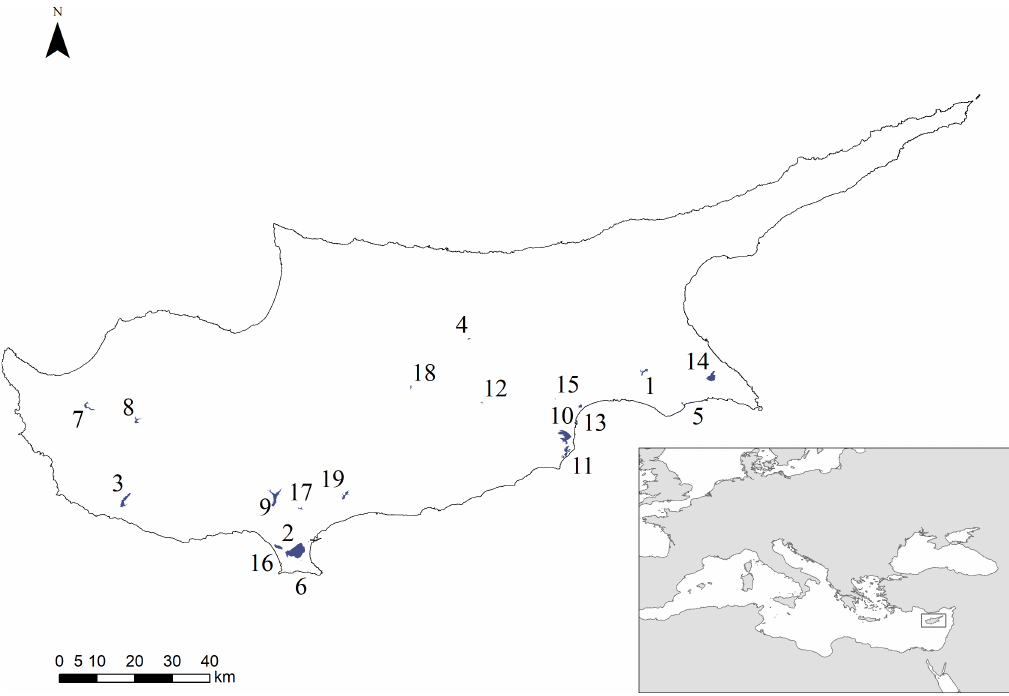
Fig 1. A map of Cyprus showing the location of the nineteen study sites. The numbers correspond to those in Table 1. The inset map on the bottom right corner shows Cyprus’ location in the eastern Mediterranean Sea (source: 2009–2017 Natural Earth). The island’s location makes it an important stopover site from millions of migratory birds.